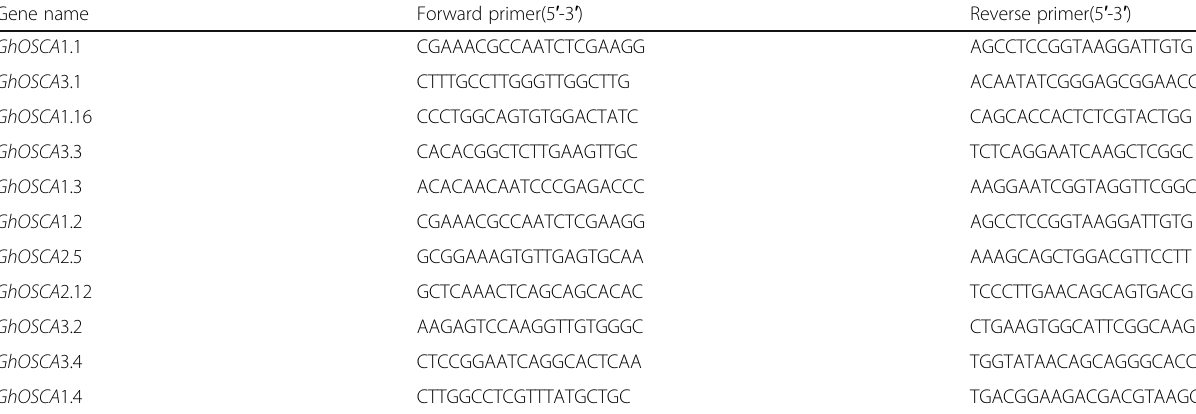
Table 1 Primers used in RT-qPCR analysis of salt and drought response